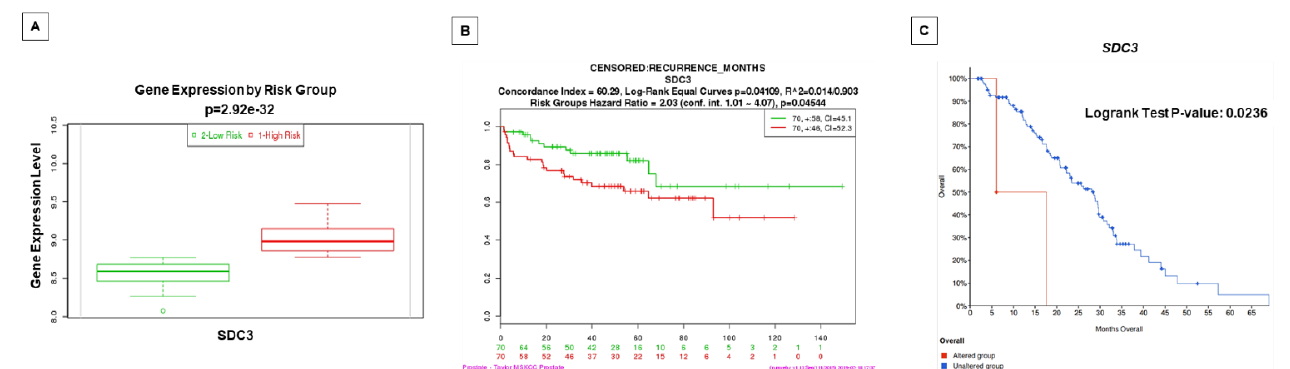
Figure 7. Gene expression of SDC3 in patients with PCa is associated with high risk/worse prognosis and lower disease- /progression-free survival. ( A ) The level of SDC3 gene expression (median) in PCa patients with low risk ( green ) and patients with high risk ( red ). Data and analyses were cataloged using the Survexpress database [40] from an MSKCC prostate study [39]. The difference between boxplots is statistically significant with p = 2.92 × 10 − 32 . ( B ) Kaplan–Meier curve displaying risk group survival of PCa patients with low risk ( green ) and high risk ( red ) of SDC3 alterations, cataloged using the Survexpress database [40] from the MSKCC prostate study [39]. Curves are significantly different, with p = 0.04544. ( C ) Overall patient survival status in Metastatic Prostate Adenocarcinoma patients with SDC3 gene-altered ( red ) and -unaltered ( blue ) groups. Data and analyses were cataloged using the cBioPortal database [41,42] (Metastatic Prostate Adenocarcinoma — SU2C/PCF Dream Team) [43].